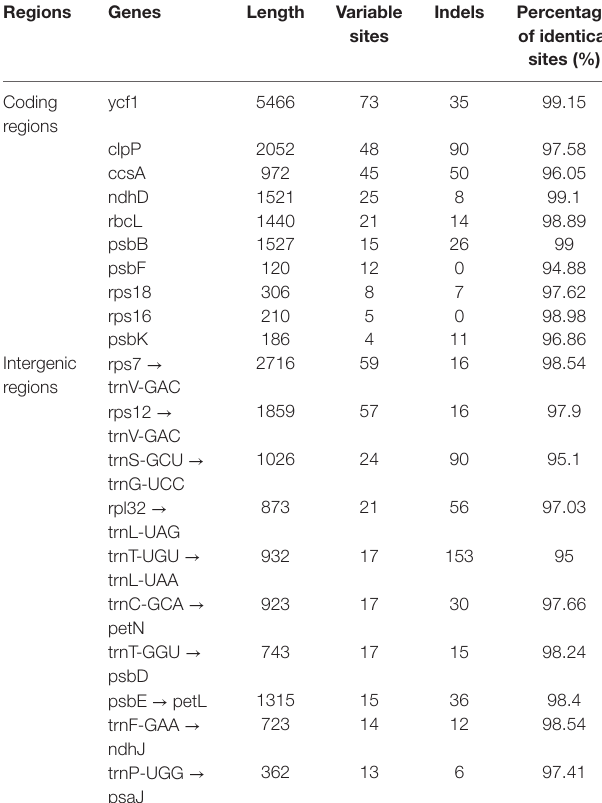
TaBLe 4 | The 10 most-divergent coding regions and intergenic regions in the six Dracaena species. Regions Genes